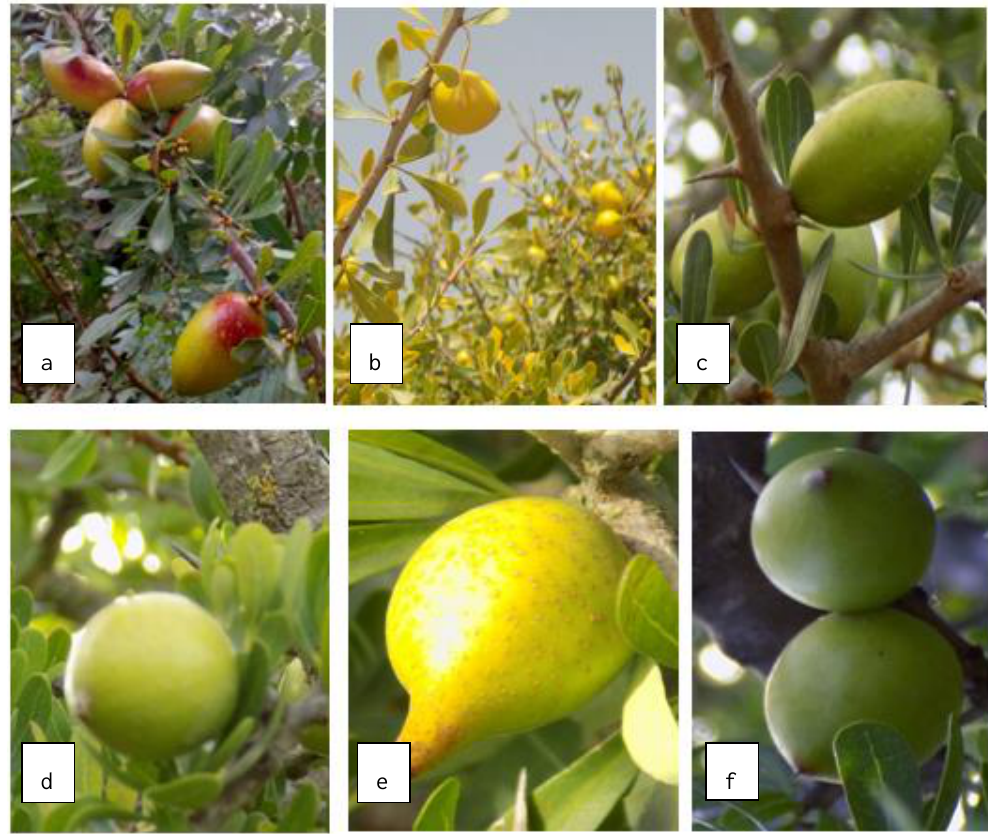
Figure 1. Variability in the shape, color of leaves and fruits ( a ); green and red argan fruits with a fusiform form and dark green leaves, ( b ); yellow argan fruits with an intermediate form and clear green leaves, ( c ); green fruits with an oval form with medium green leaves, ( d ); green fruit with a round form, ( e ); green fruit with an apiculated form, ( f ): green fruits with an intermediate form. Table 1. Results of analysis of variance (ANOVA) made for comparison of all variables chosen. Codes